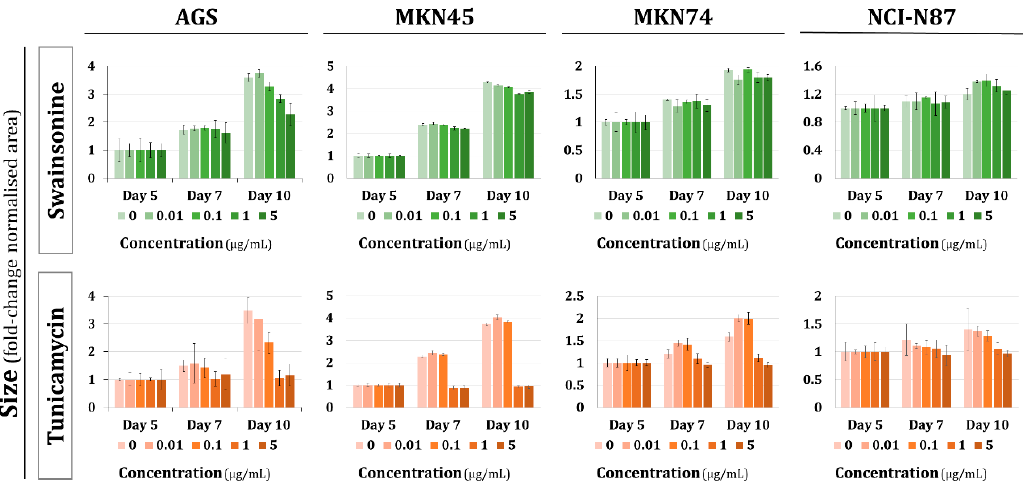
Figure 2. Glycosylation interference analysis for gastric spheroid formation. Multicellular tumor spheroids were grown for five days and treated with different concentrations of glycosylation inhibitor swainsonine or tunicamycin at different time points. Values represent variation in size at each time point in comparison to the value at day 5. Values are means ± SD of at least n = 3 spheroids. For each condition, two independent experiments were performed.